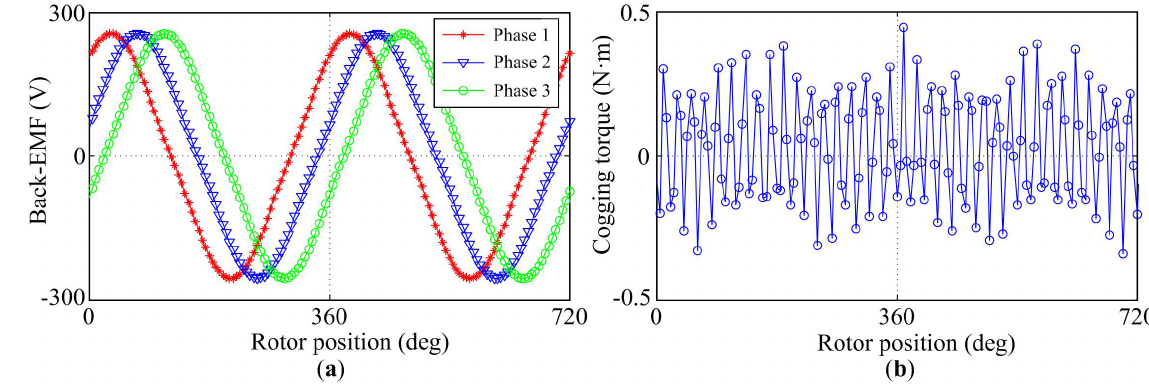
Figure 2. Static performance. ( a ) Back-EMF; ( b ) Cogging torque.